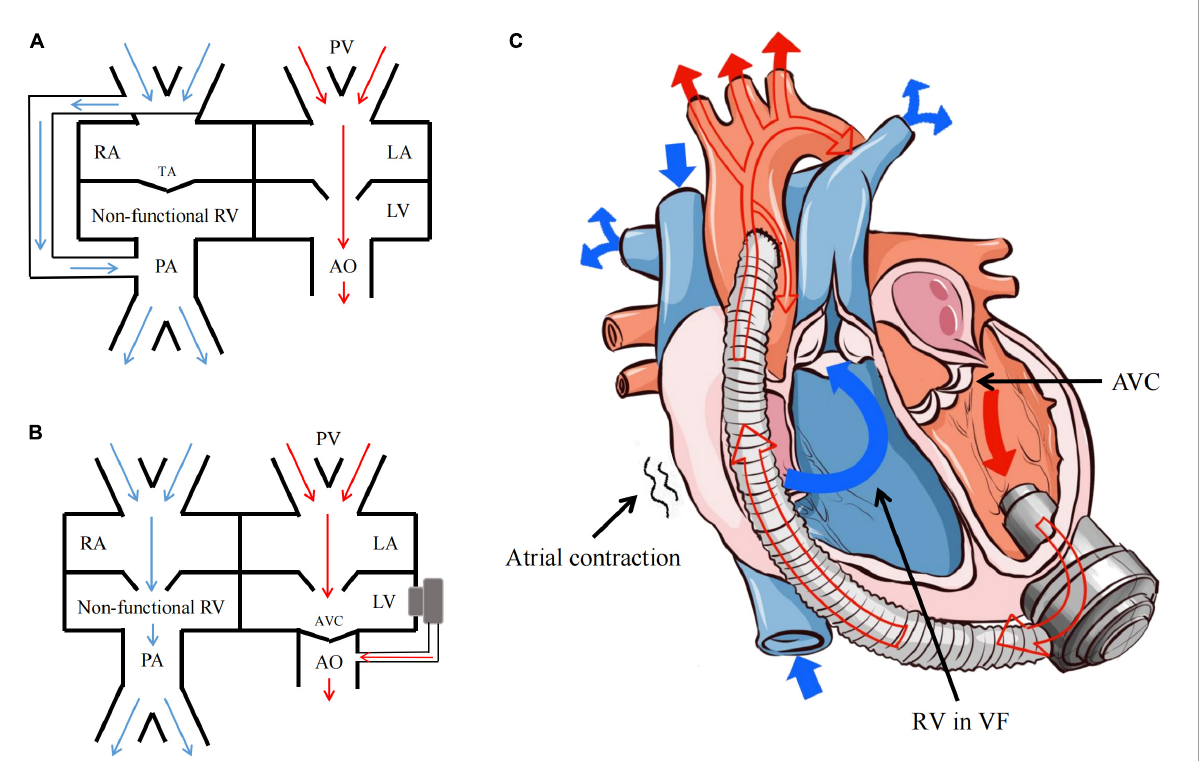
FIGURE4 Fontan circulation and the hemodynamics of VF after CF-LVAD implantation. (A) Fontan circulation; (B) the hemodynamics of VF after CF-LVAD implantation; (C) the model diagram of hemodynamics in the VF state after CF-LVAD implantation. RA, right atrium; RV, right ventricle; LA, left atrium; LV, left ventricle; PA, pulmonary artery; PV, pulmonary vein; TA, tricuspid atresia; AVC, aortic valve closure.